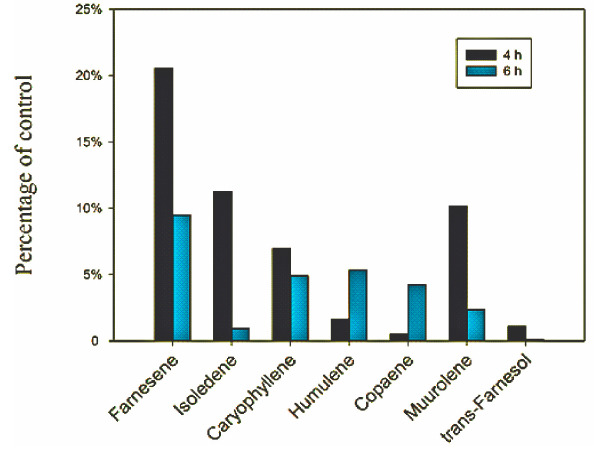
Figure 7. The percent reduction in emission of selected volatile organic compounds from flowers of J. sambac ‘Bifoliatum’ sprayed with 50 μ m/L lovastatin.